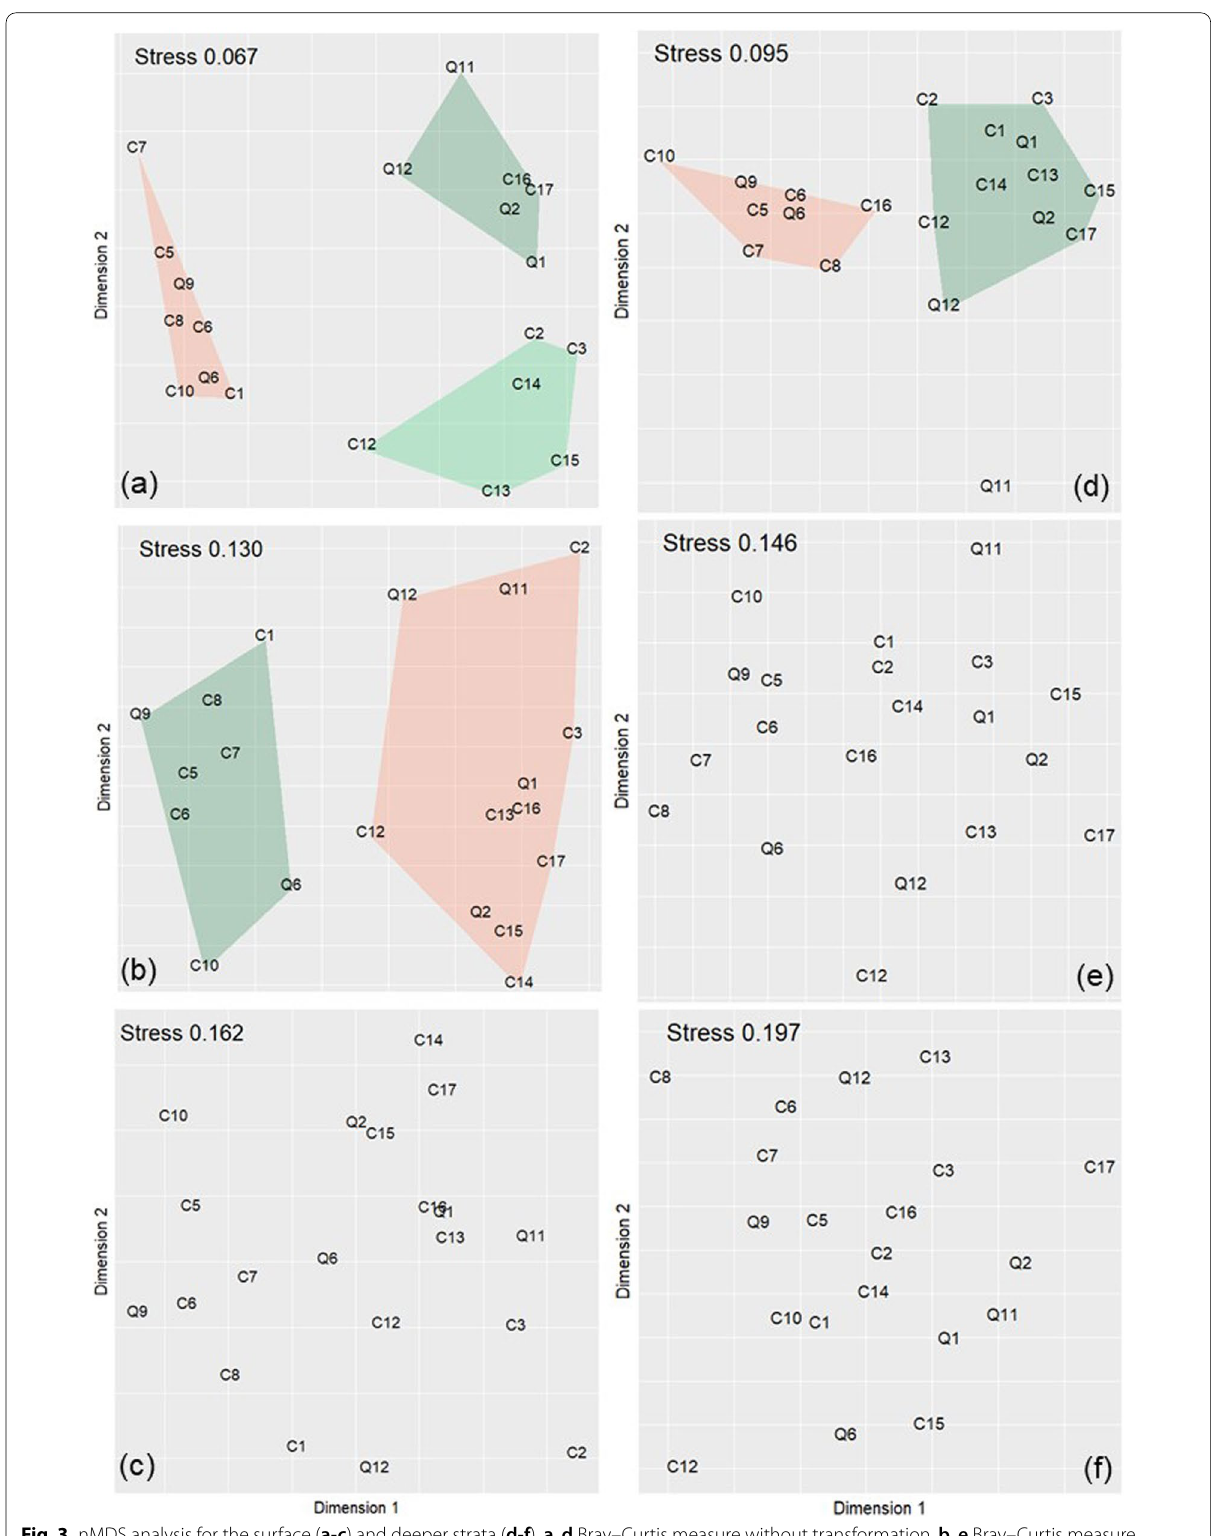
Fig. 3 nMDS analysis for the surface ( a-c ) and deeper strata ( d-f ). a , d Bray–Curtis measure without transformation. b , e Bray–Curtis measure transformed to fourth root. c , f Jaccard measure converted to presence‑absence. Color polygons in ( a , b and d ) indicate statistically different